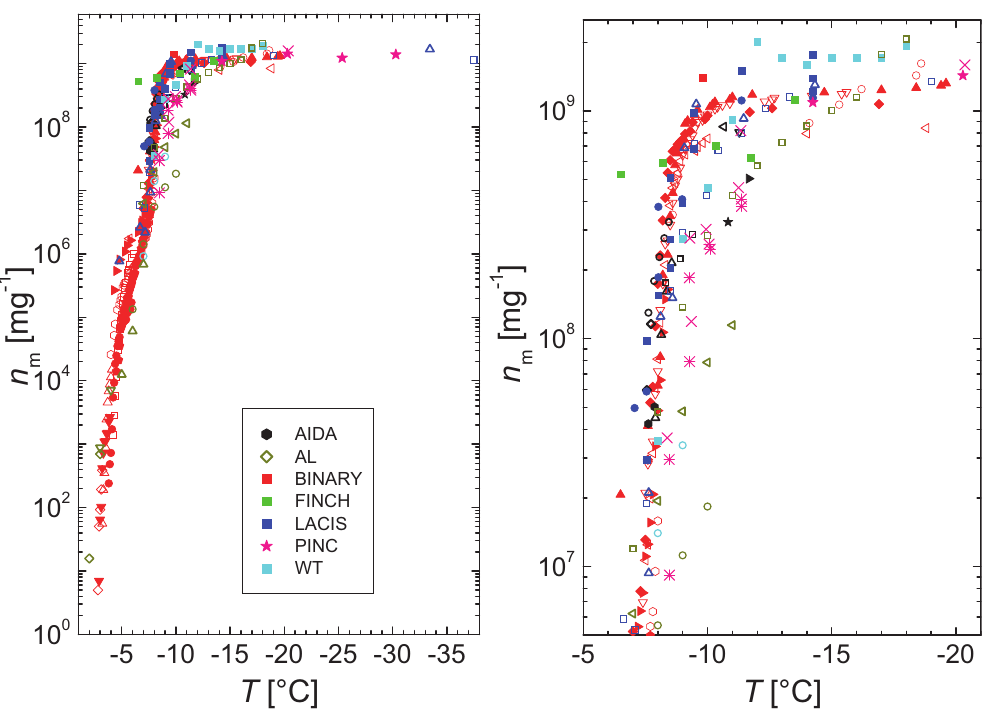
Figure 11. Number of INM per dry Snomax mass as a function of temperature, derived from measured f ice of all instruments, i.e., for all data shown in Figs. 5 to 8. BINARY data are solely displayed in red, but otherwise the same symbols and color codes are used as in Figs. 5 to 8; i.e., in all cases data from one instrument are always displayed in a single color. The right panel is similar to the left, zooming in on values for 5 × 10 6 mg − 1 <n m < 2 . 5 × 10 9 mg − 1 and on temperatures > − 21 ◦